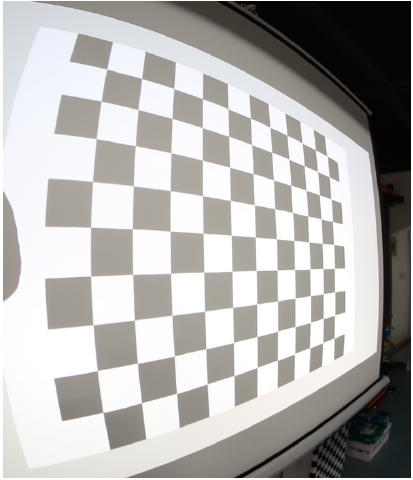
Figure 4: Distorted image captured by fisheye lens with fixed focal